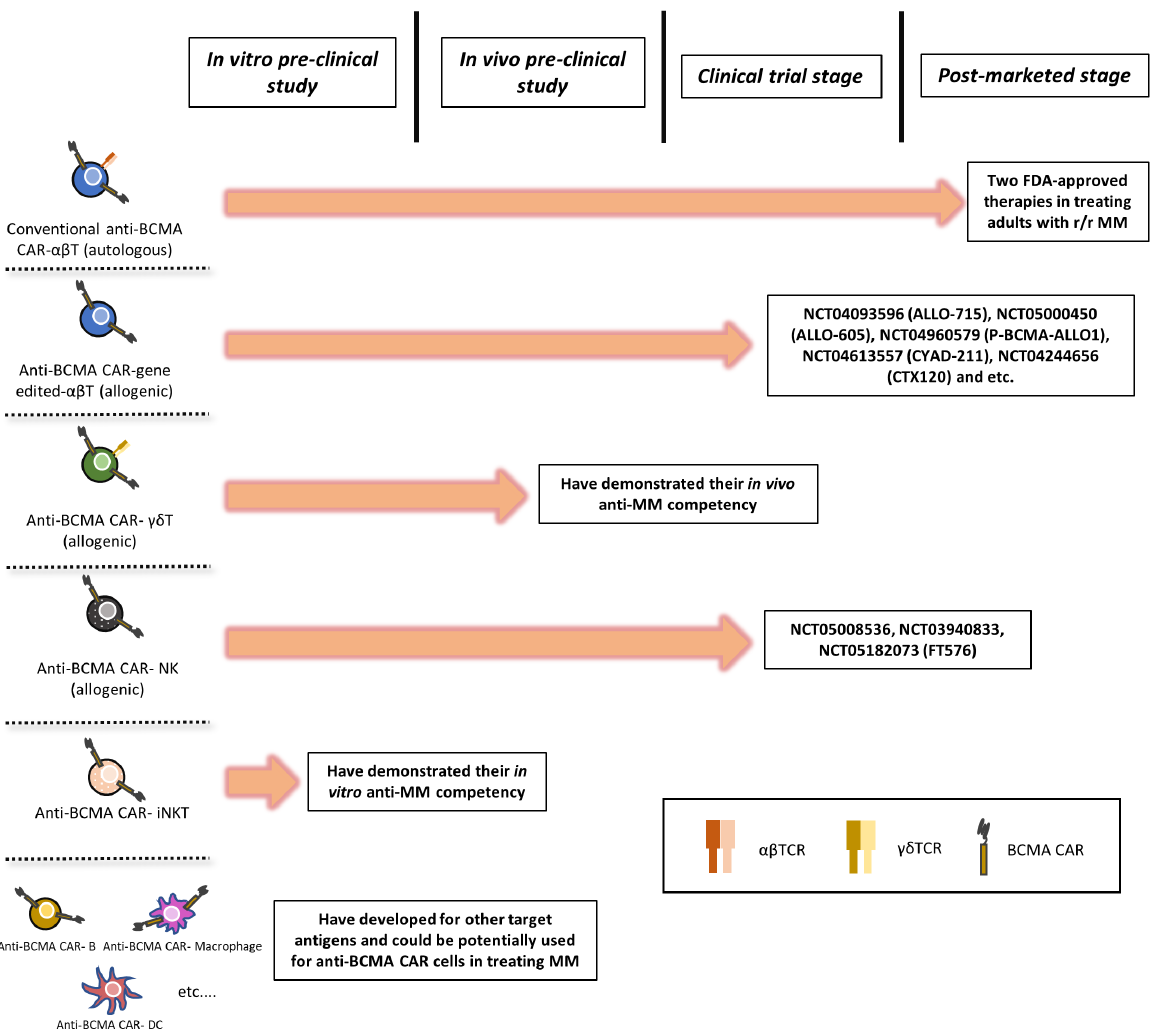
Figure 3. The current development stages of major types of anti-BCMA CAR-based immune cells.